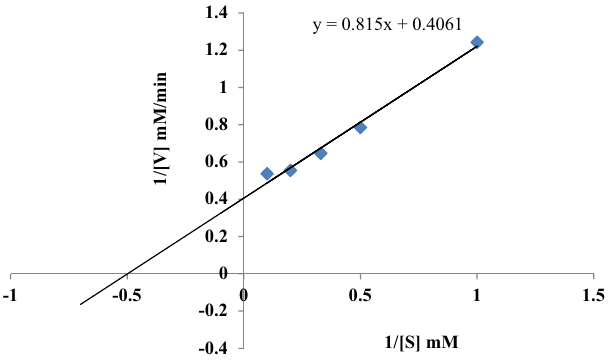
Figure 5. The Lineweaver–Burk plot of purified Glacc110 of G.